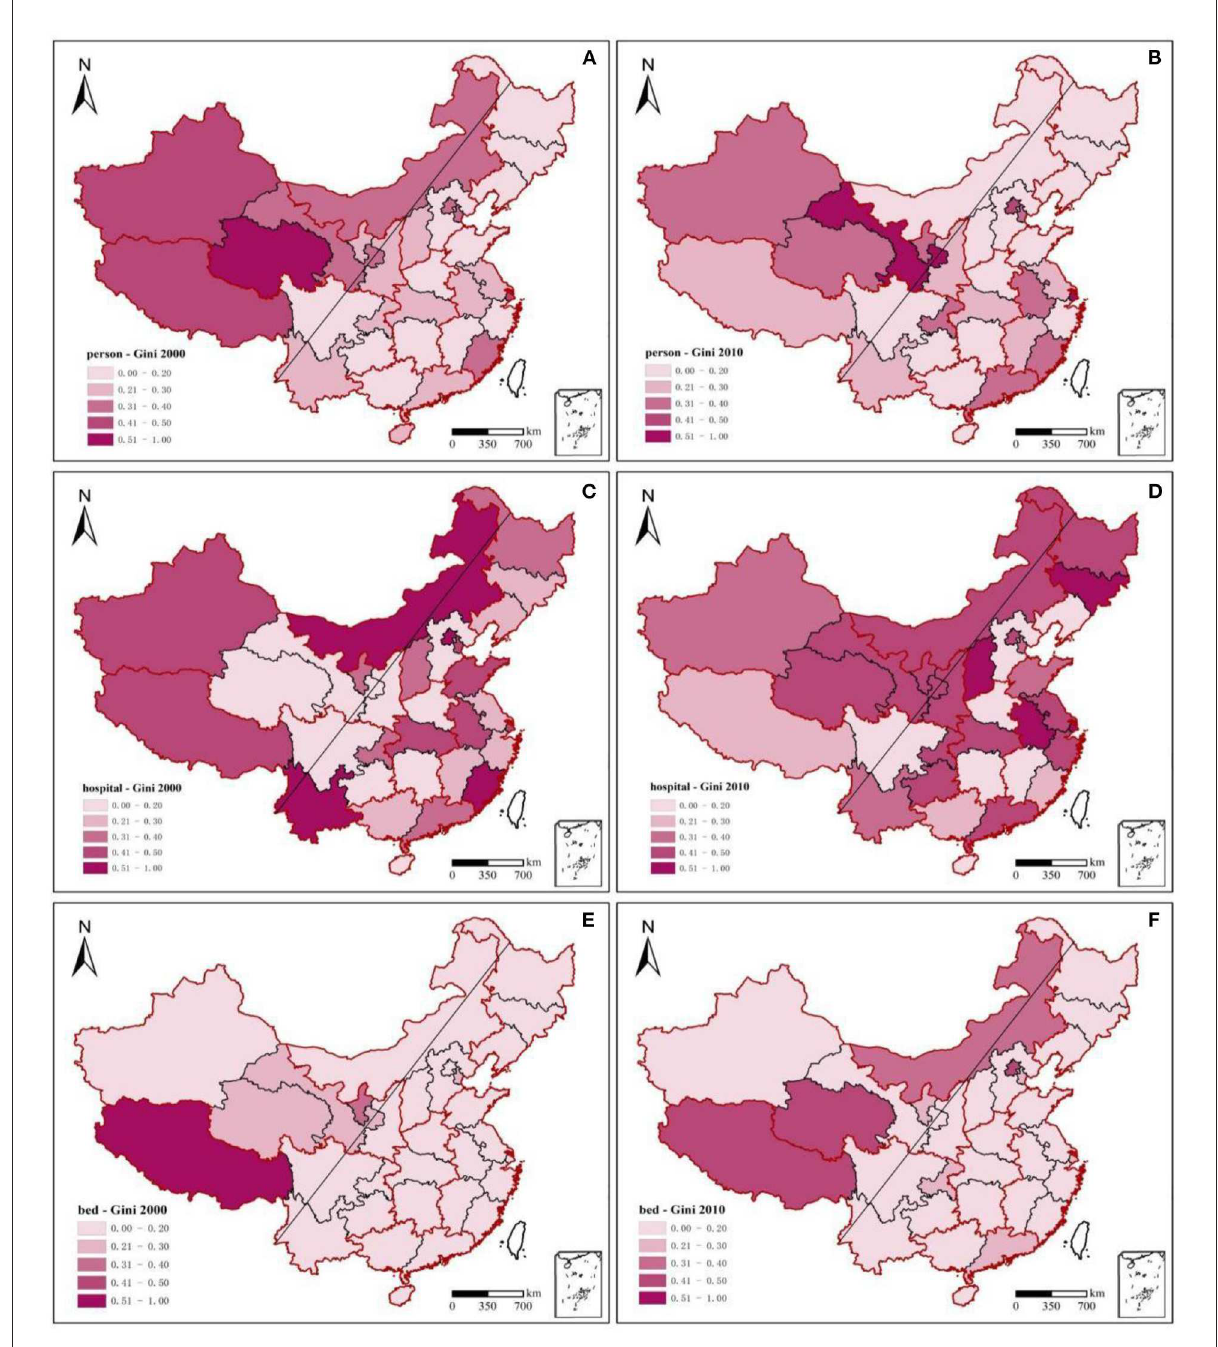
FIGURE4 Gini coefficients of health resources across 31 provinces, 2000–2010.